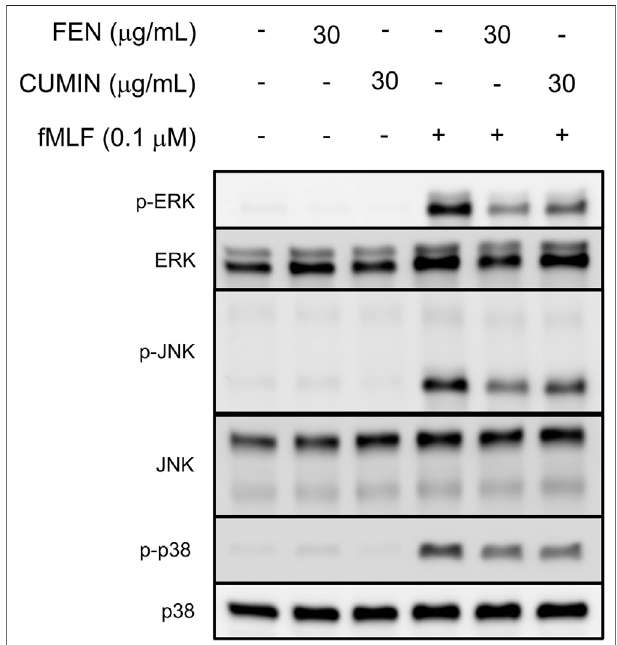
FIGURE 7 | Fennel (FEN) and cumin (CUMIN) volatile oils inhibit fMLF- induced phosphorylation of p38, ERK, or JNK in human neutrophils. Human neutrophilswereincubated with DMSO (ascontrol), fennel(FEN, 30 μ g/ml), or cumin (CUMIN, 30 μ g/ml) volatile oils for 5 min and stimulated with or without fMLF for 25 s. Phosphorylation of ERK, JNK, and p38 was analyzed by immunoblotting with antibodies raised against the phosphorylated and total form of each protein ( n (cid:2)